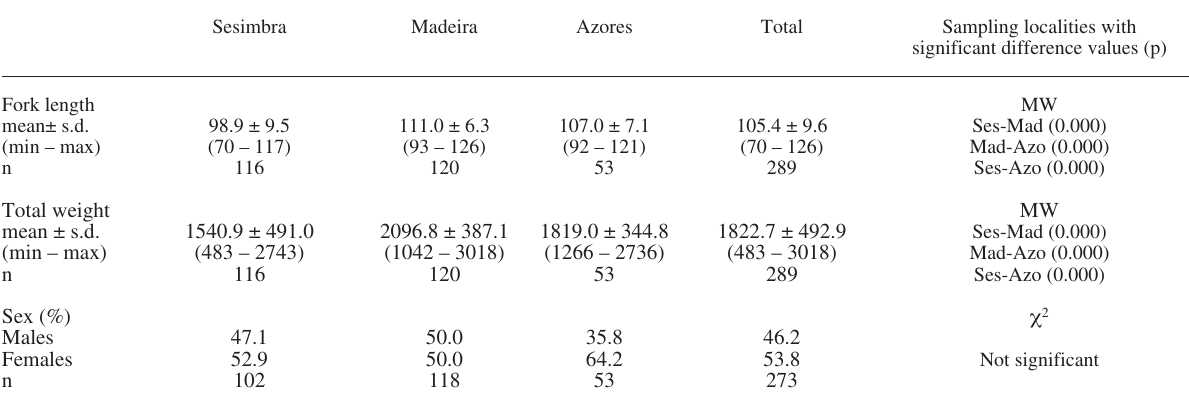
Table 2. – Fork length (cm), total weight (g), and sex ratio of Aphanopus carbo , and statistical significance between the values recorded for the three sampling localities (Ses, Sesimbra; Mad, Madeira; azo, azores) assessed by Mann-Whitney’s u (MW) and chi-square ( c ²) tests (s.d.= standard deviation, min.= minimum, max.= maximum) . Sesimbra Madeira azores total Sampling localities with significant difference values (p)